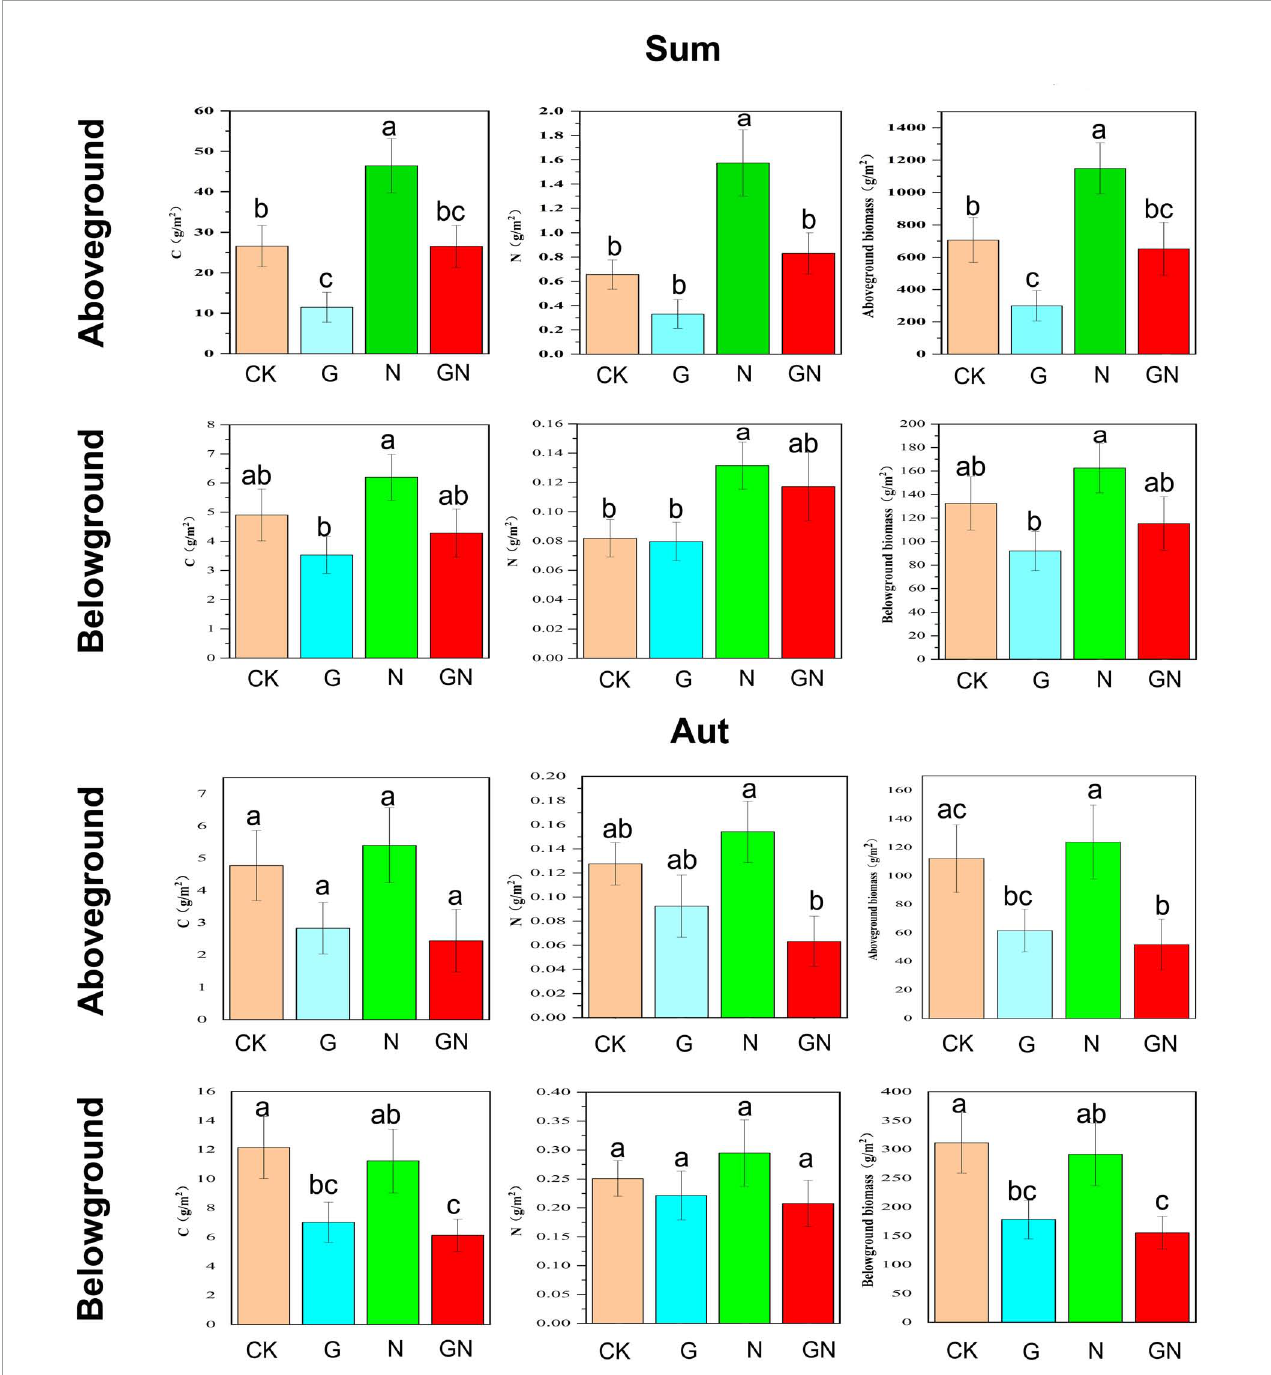
FIGURE3 Plant functional traits with each treatment group (C content, N content and biomass of aboveground and belowground). Sum, summer; Aut, autumn; CK, control; G, glyphosate addition; N, chemical nitrogen addition; GN, glyphosate and N addition. Data (a, b, ab, and bc) that do not share a letter are significantly different between treatments ( P <